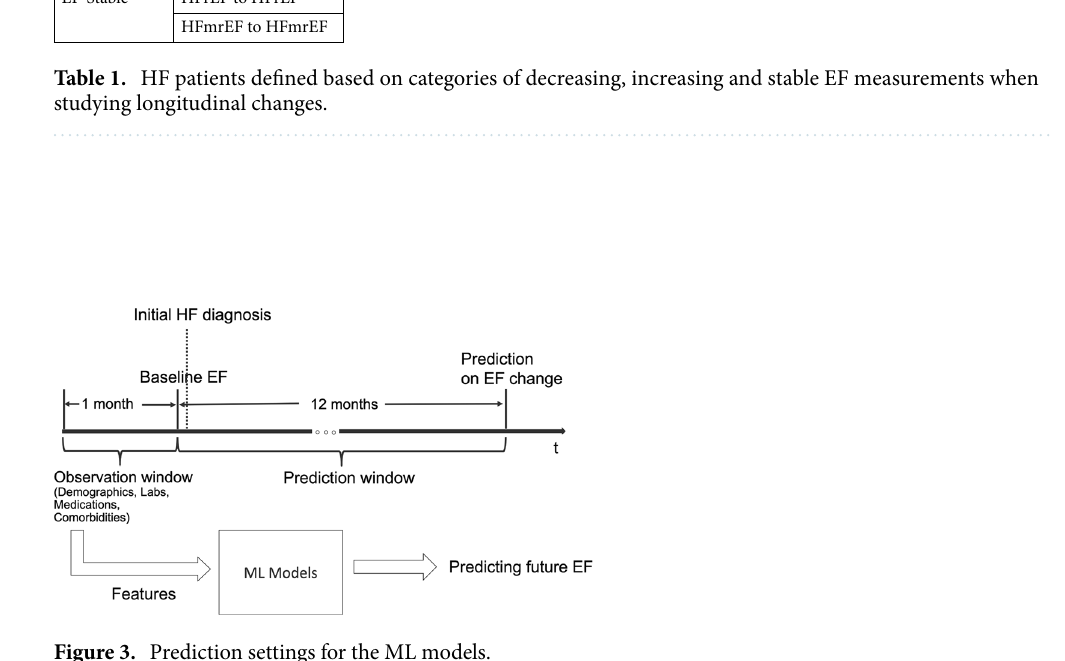
Figure 3. Prediction settings for the ML